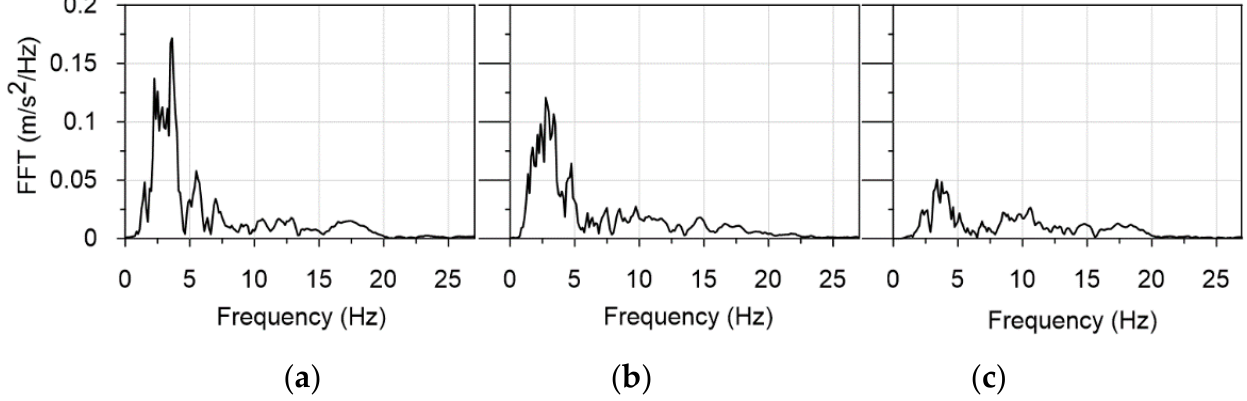
Figure 2. The frequency spectra of the recorded accelerations: ( a ) horizontal direction W – E; ( b ) horizontal direction N – S; ( c ) vertical direction Z.